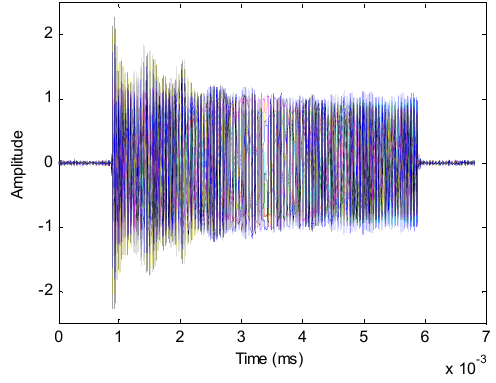
Figure 17. Received signals expressed in time domain.